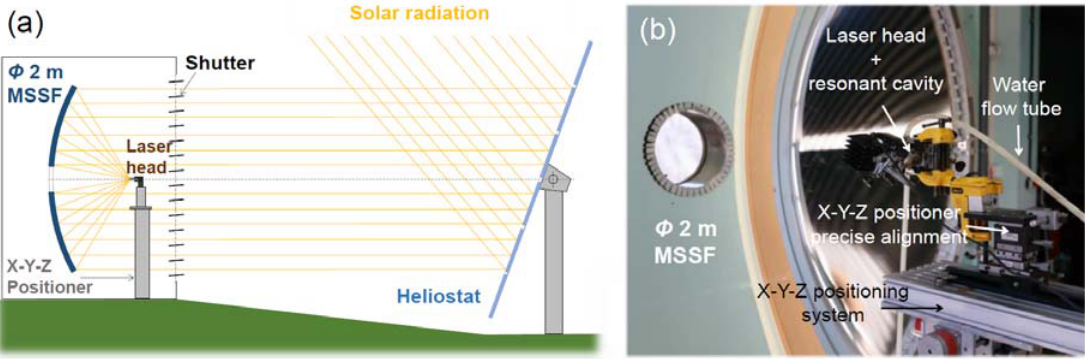
Figure 3. ( a ) Design of the PROMES ‐ CNRS solar facility. ( b ) Photograph of the Medium Size Solar Furnace (MSSF) and the solar laser head mounting.